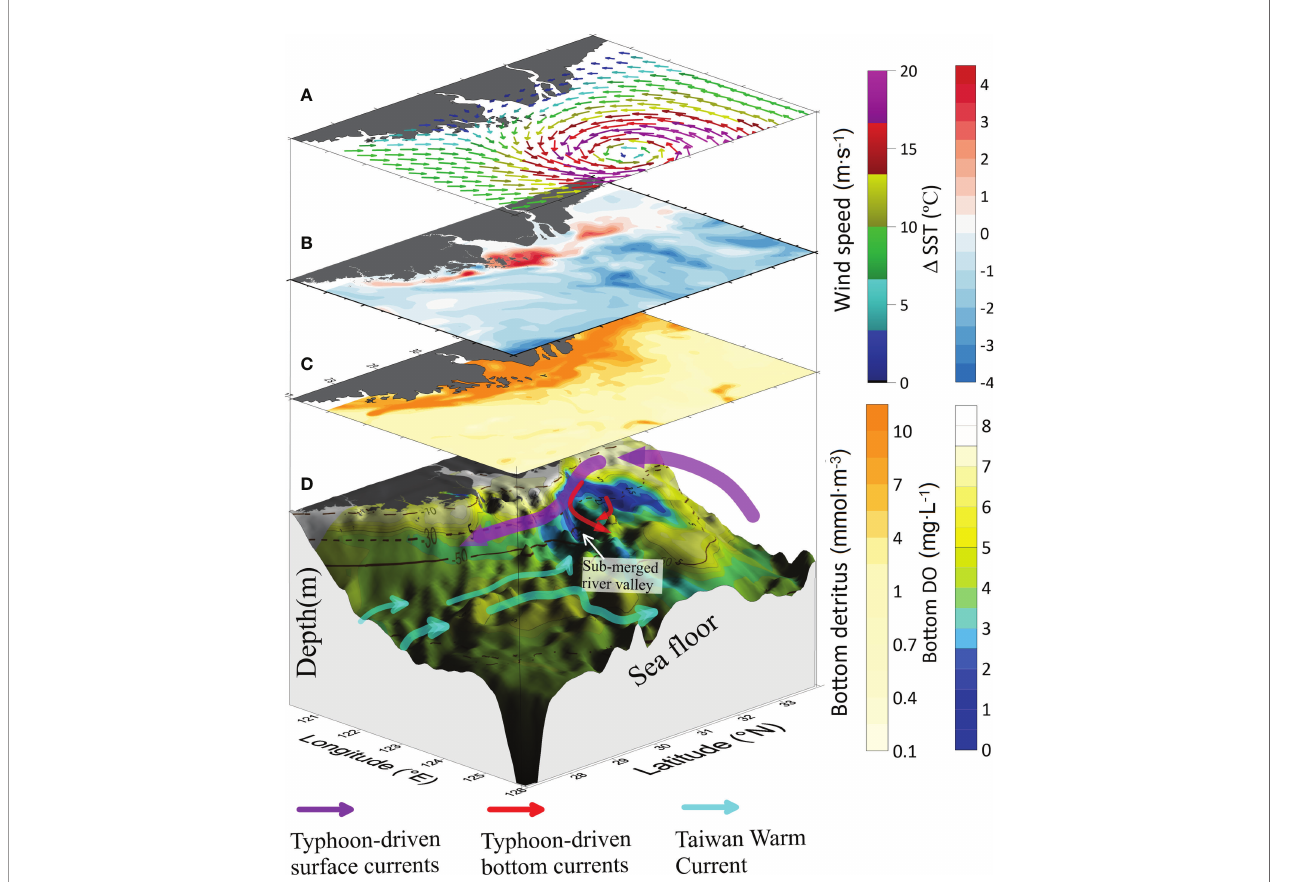
FIGURE 15 | Schematic diagram for the coastal ocean warming induced by the passage of Bavi and the impact of the typhoon ’ s passage on migration of hypoxic water and redistribution of particulate organic matter: (A) the typhoon wind fi eld; (B) variation in the sea surface temperature (SST) before and after the typhoon passage; (C) distribution of planktonic detritus organic matter before the typhoon ’ s passage; and (D) the dissolved oxygen (DO) concentration before the typhoon ’ s passage, bathymetry, and